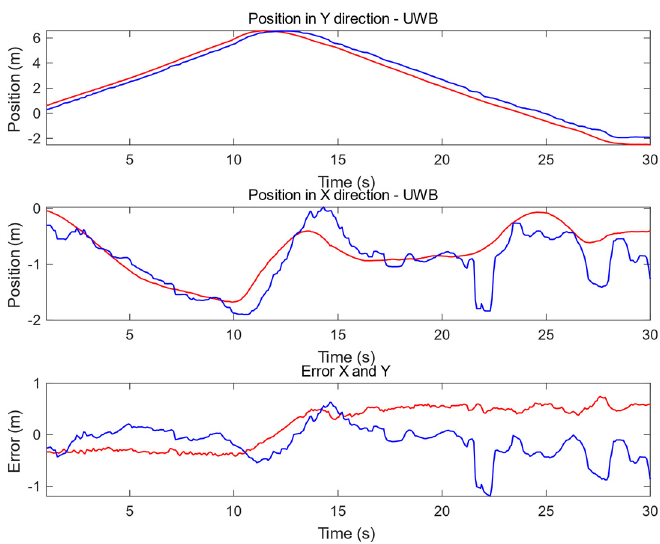
Figure 16. Plot present positioning results and error from UWB in comparison to SLAM in the environment “corridor part A.” UWB (blue) displacement with respect to SLAM (red): ( top ) vertical y position, ( middle ) horizontal X position, ( bottom ) error—UWB displacement vector in horizontal (blue) and vertical (red)